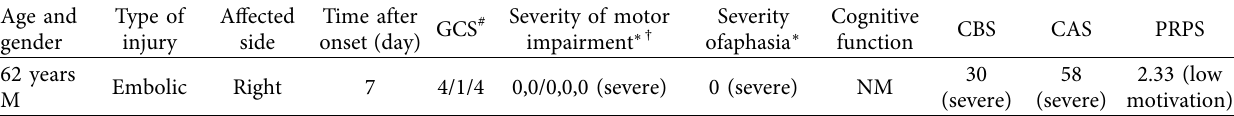
Figure 1: Brain images of the study patient. Diffusion-weighted magnetic resonance images of the patient (day 3 from stroke onset). Multiple infarctions in the bilateral cerebrum were observed, mainly in the left parietal and occipital cortex/bilateral prefrontal cortex, as cortical lesions basal ganglia (left caudate nucleus) were presented as a subcortical lesion. Table 1: Participant